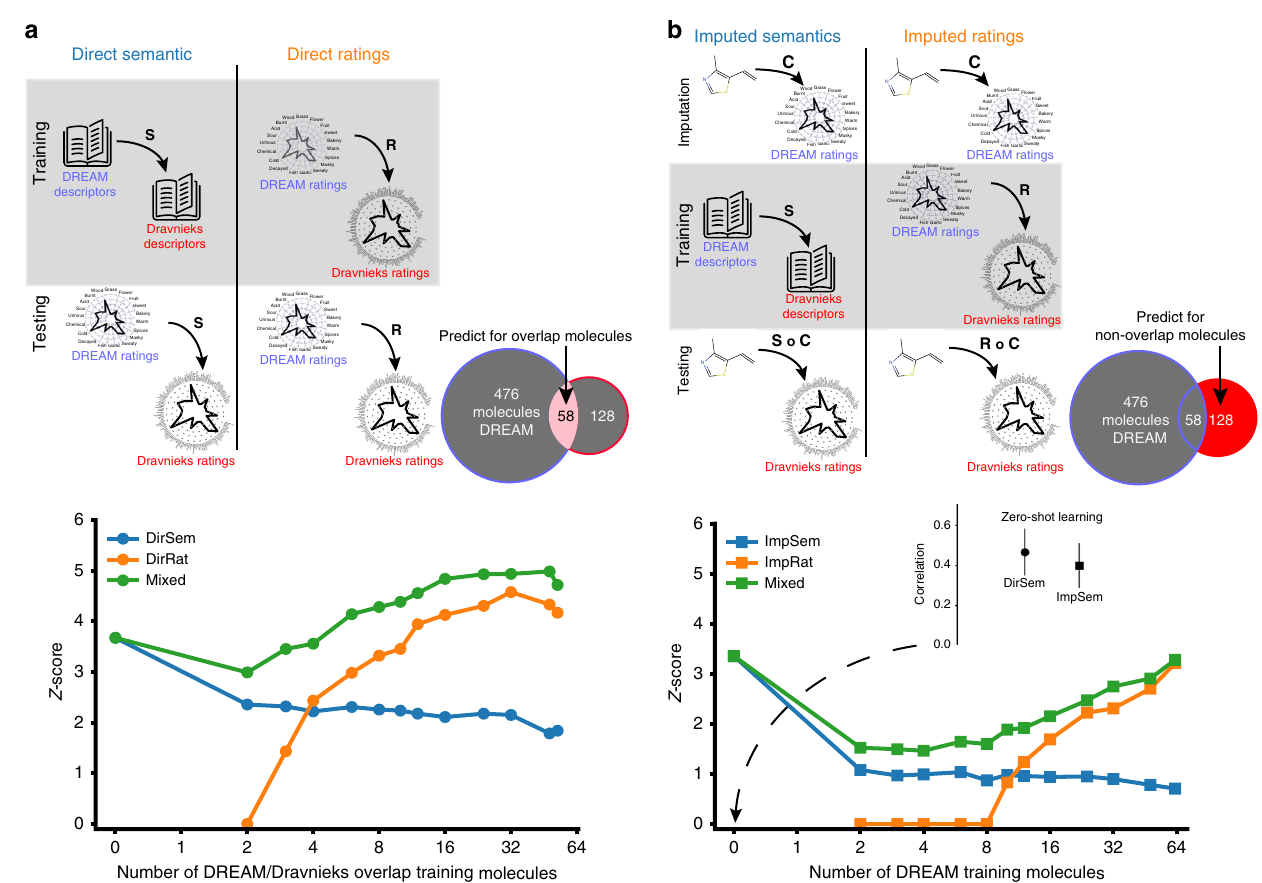
Fig. 3 Predicting olfactory perception across descriptor sets and molecules. a Top Schematic of the direct models for predicting ratings. During training (top row), the direct semantic model ( DirSem left column) learns a transformation S from DREAM descriptors ’ semantic vectors to Dravnieks descriptors ’ semantic vectors. Direct ratings model ( DirRat right column) learns a transformation R from molecule ratings on DREAM descriptors to molecule ratings on Dravnieks descriptors. During testing (bottom row), the DirSem and DirRat models use transformations S and R , respectively, to predict molecule ratings on Dravnieks descriptors from the ratings given on DREAM descriptors. Note that during training, DirSem uses no molecules while DirRat uses the shared set of 58 molecules. Both models are tested on these 58 molecules, averaging across 100 repetitions of 10-fold cross-validation. Bottom : The performance of DirSem (blue dots) and DirRat (orange dots) as well as a their averaged mixed model (green dots), as the number of molecules used in training is increased. b Top: Schematic of the indirect models for predicting ratings. During imputation (top row), both models learn the same transformation C from chemoinformatic properties to the ratings on the DREAM descriptors. During training (middle row), the two models imputed semantics ImpSem and imputed ratings ImpRat learn transformations S and R using the same procedure as the training phase of DirSem and DirRat , respectively. During testing (bottom row), the DirSem and DirRat models use the transformations S ◦ C and R ◦ C , respectively, to predict molecule ratings on Dravnieks descriptors from the ones given on DREAM descriptors. Note that the ImpSem model uses no molecules during training, while the ImpRat model uses molecules from the set of 70 molecules present only in the Dravnieks dataset during training. Both models are tested on these 70 molecules, using cross-validation. Bottom: The performance of the ImpSem (blue squares) and ImpRat (orange squares) models and the mixed model (green squares), as the number of molecules used in training is increased. Inset shows the value of the correlations for the DirSem (black dots) ImpSem (black squares) when no molecules are used during